Question: State the chart type depicted above.
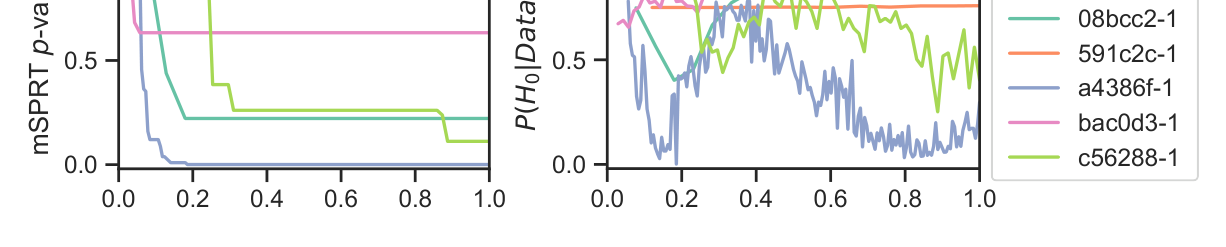
Answer: histogram